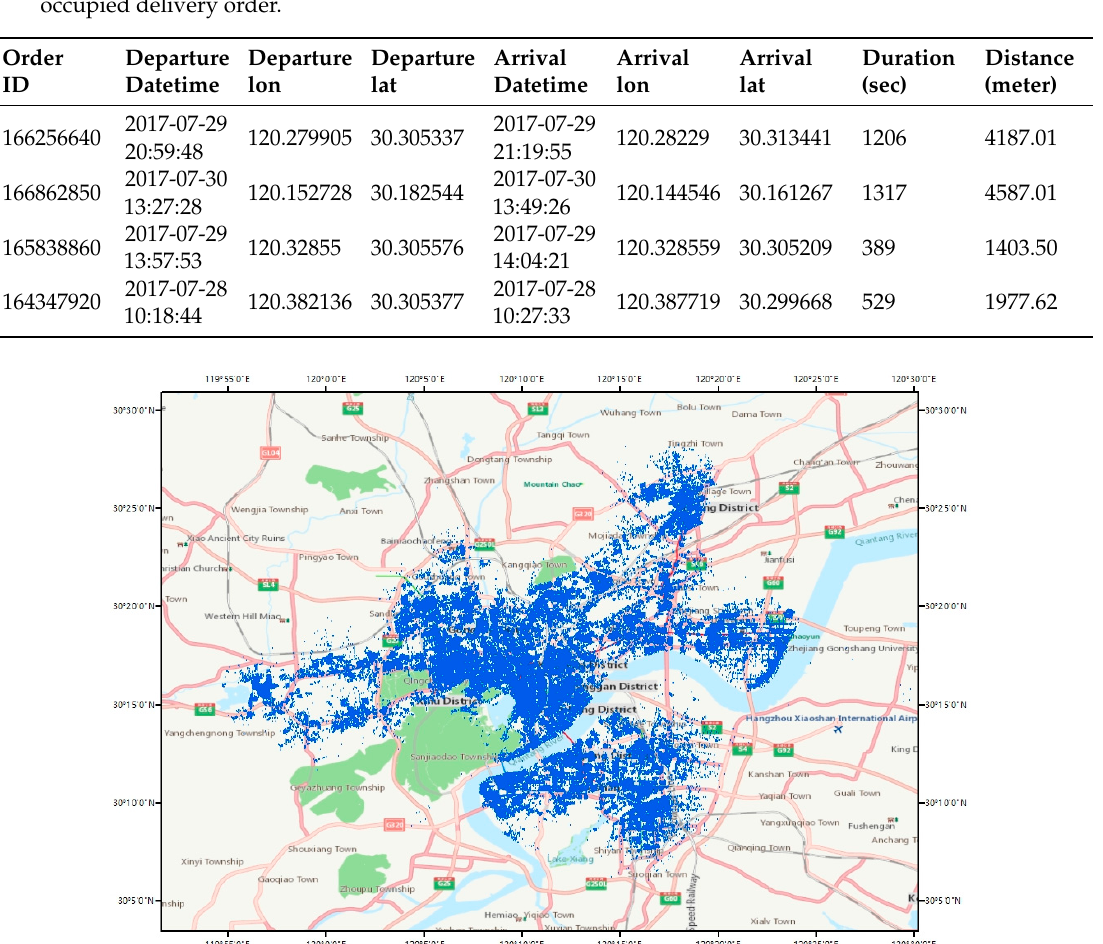
Figure 2. Location distribution of the food delivery destination points in the study area.